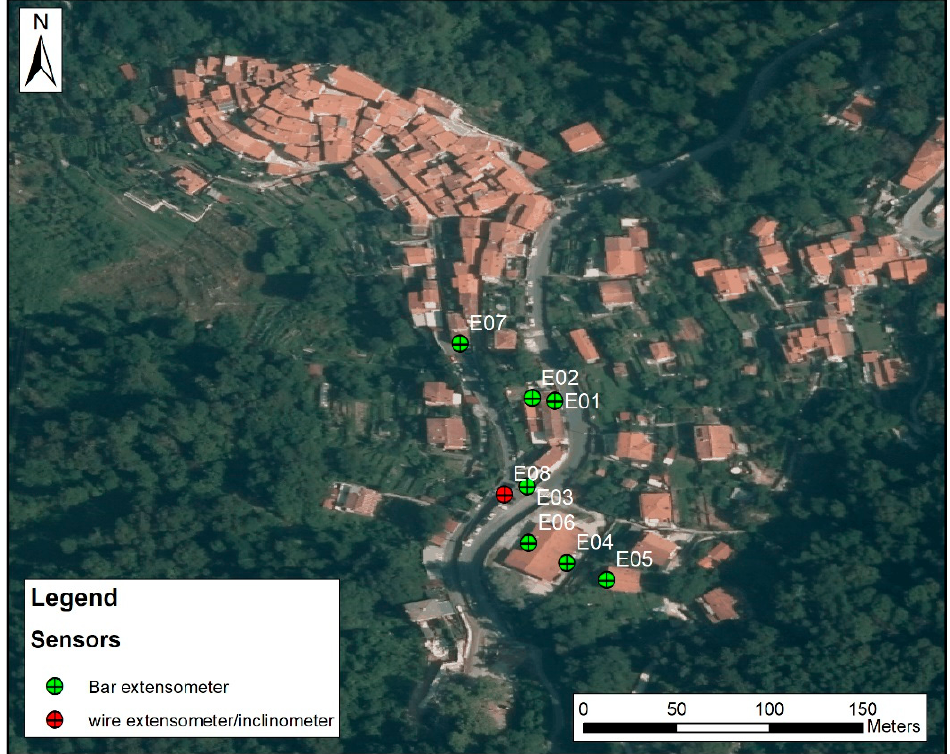
Figure 3. Location of the in situ sensors included in the monitoring system.